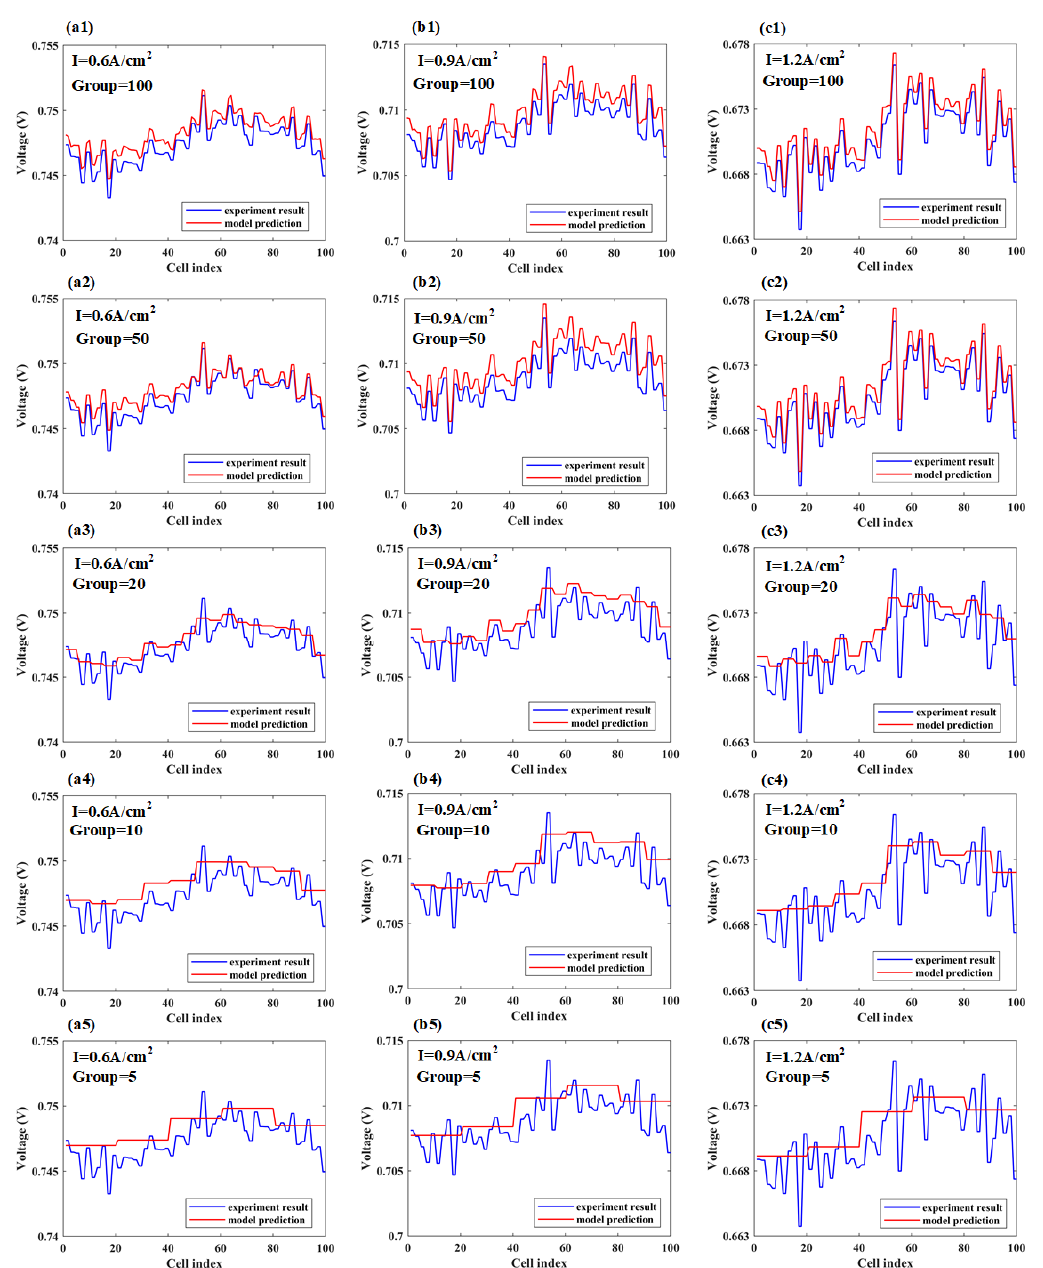
Figure 7. Comparison between the model and experiment results of cell voltage distributions with the assembly torque of 14 N.m under different load current densities: ( a1 , a2 , a3 , a4 , a5 ) 0.6 A/cm 2 ; ( b1 , b2 , b3 , b4 , b5 ) 0.9 A/cm 2 ; ( c1 , c2 , c3 , c4 , c5 ) 1.2 A/cm 2 .